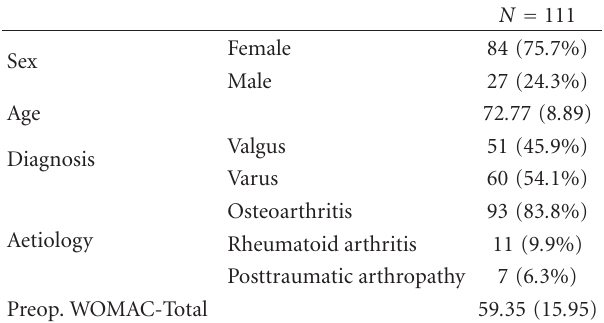
Table 1: Baseline data. Results are expressed as mean (SD) for quantitative data and as n (%) for qualitative